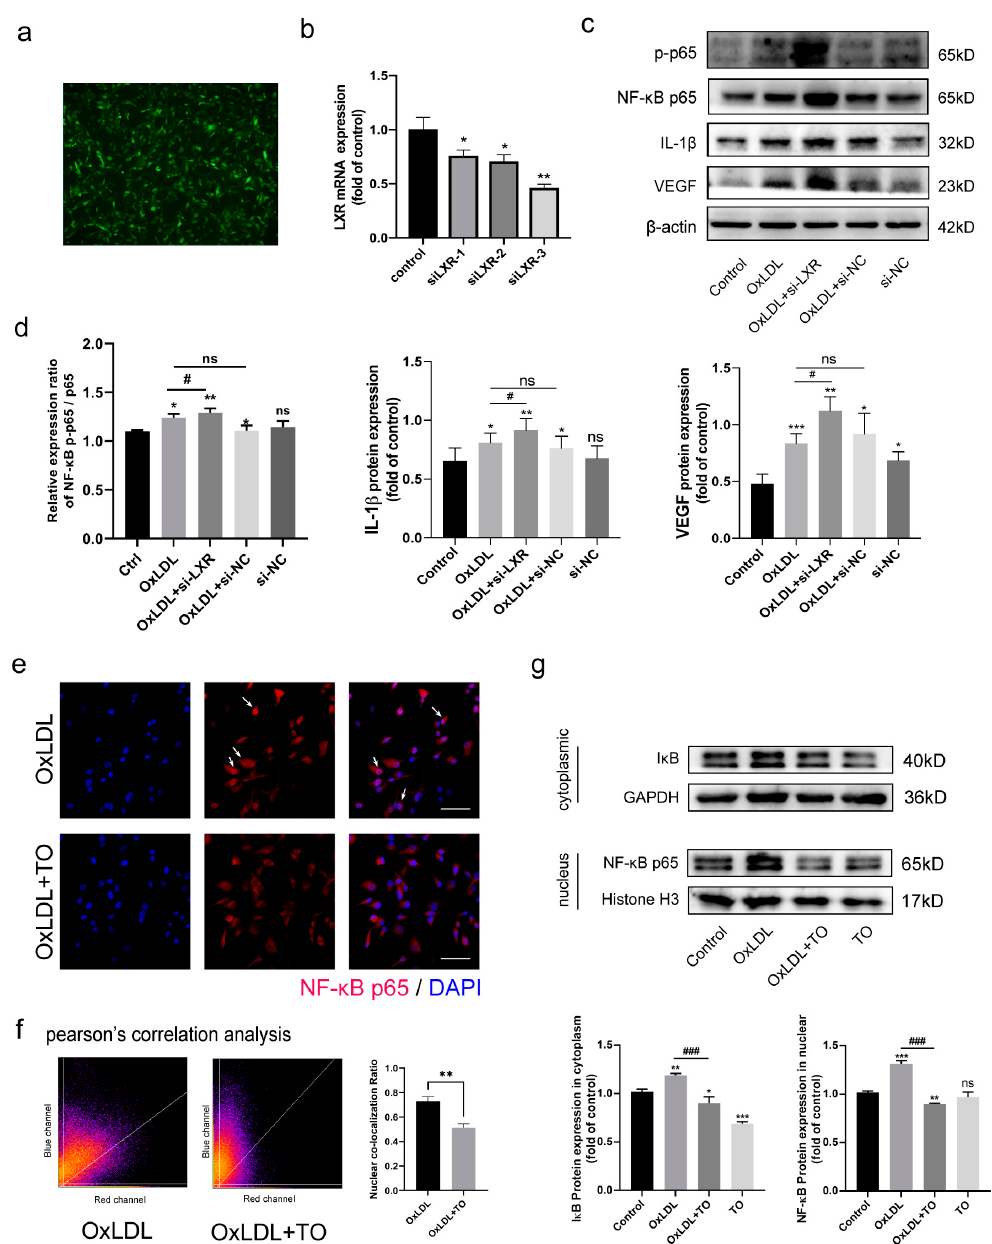
Figure 5. Effect of the specific LXR knockout and LXR agonists on the NF- κ B route. ( a ) Cell transfer siLXR-GFP efficiency. ( b ) LXR mRNA expression, n = 3, * p < 0.05, ** p < 0.01 vs. control group. ( c ) Western blotting was employed to detect the manifestation of NF- κ B p-p65, IL-1 β , and VEGF. ( d ) Quantification of NF- κ B p-p65, IL-1 β , and VEGF protein expression. * p < 0.05, ** p < 0.01, and *** p < 0.001 vs. control group, ns indicates p > 0.05, # p < 0.05 vs. OxLDL group. ( e ) Immunofluorescent images of NF- κ B p65 (red) and DAPI staining of nuclear (blue), arrows labeled NF- κ B p65 expression in nuclear, bars = 50 µ m. ( f ) Pearson’s correlation analysis p65 transfer to nuclear and quantified nuclear co-localization ratio, ** p < 0.01 vs. OxLDL group. ( g ) Western blotting was employed to detect the manifestation of NF- κ B route protein in cytoplasm or nucleus with GAPDH and histone in order to maintain internal control, and quantified. Data are presented as mean ± SEM, n = 3, * p < 0.05, ** p < 0.01, and *** p < 0.001 vs. control group, ### p < 0.001 vs. OxLDL